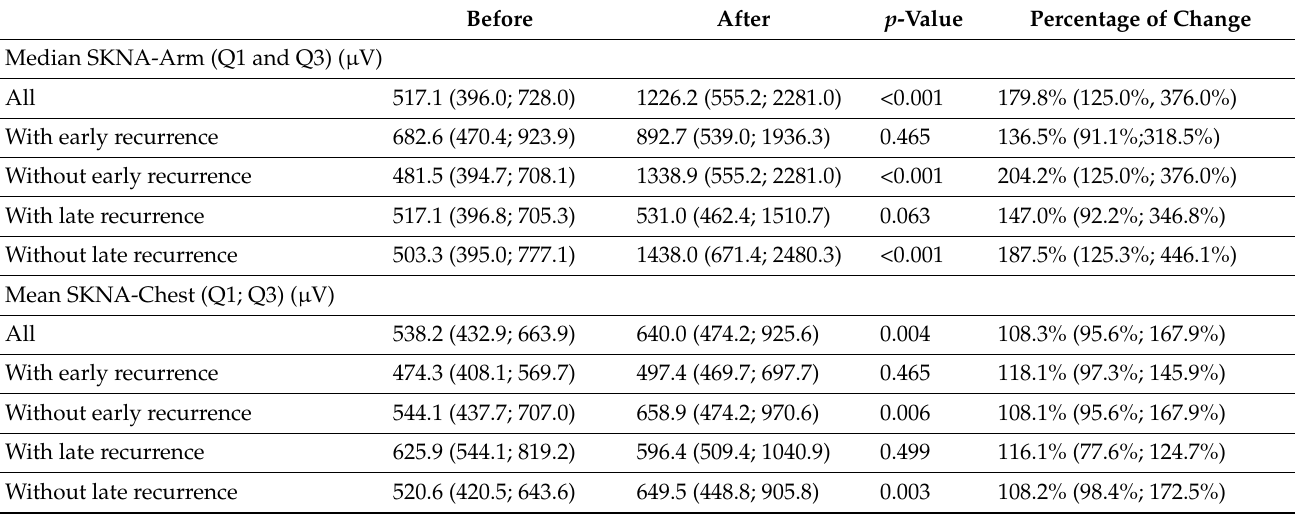
Table 3. Comparisons of mean SKNA between before and after the ablation ( n =